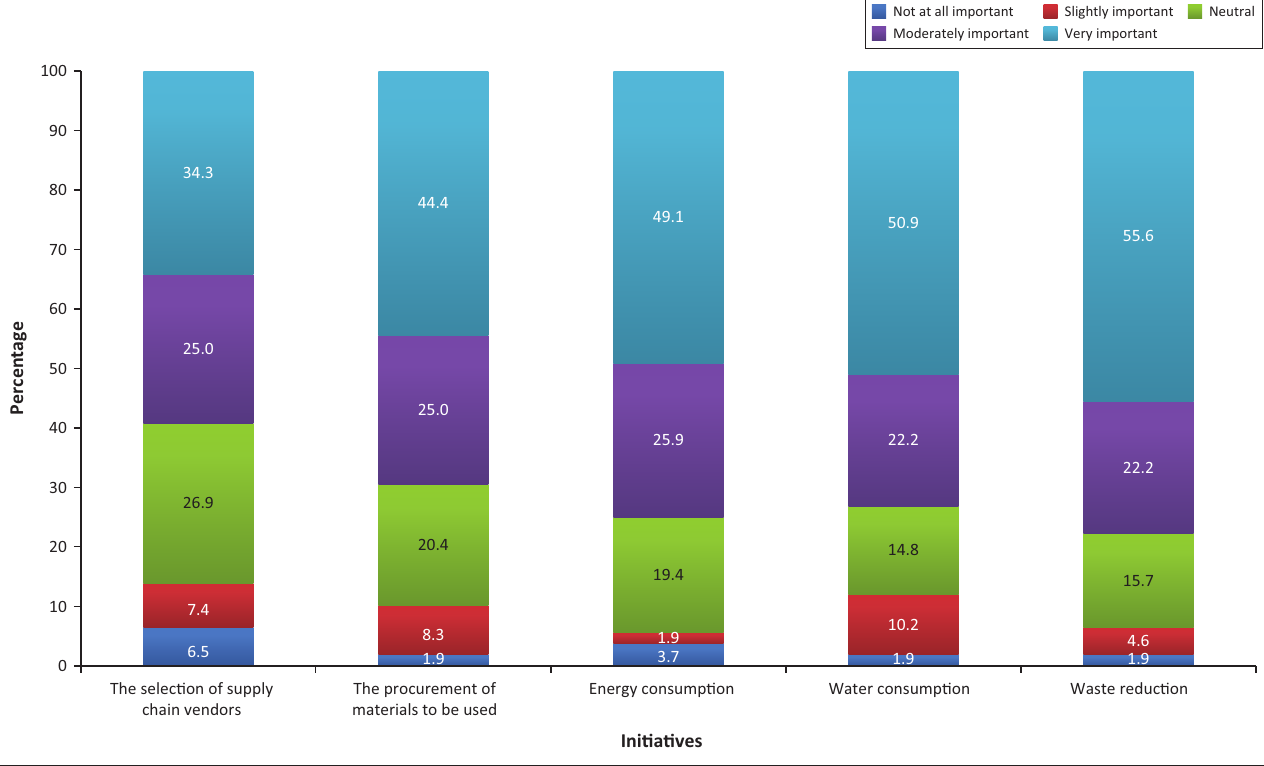
FIGURE 6: Sustainable initiatives